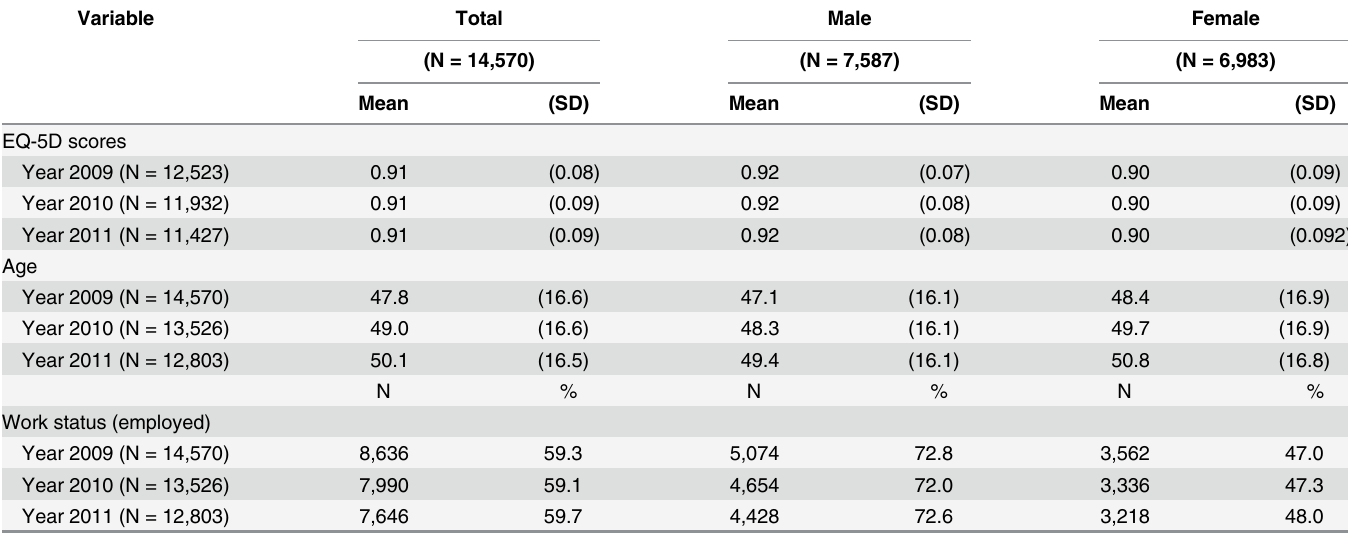
Table 1. Charactersitics of study sample stratified by gender group.